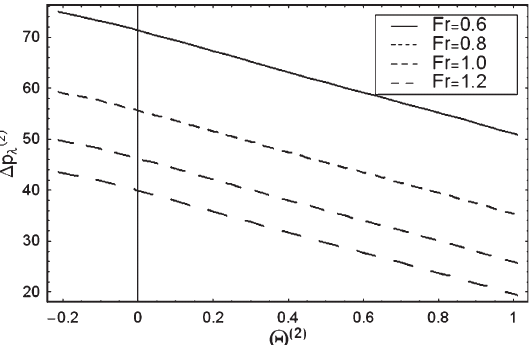
Fig. 3. Effect of Deborah number (cid:15) on variation of (cid:16)p (2) for a = 0 . 2, b = 0 . 5, d = 0 . 8, Re = 10, β = 0 . 1, Fr = 1, sin α = 0 . 5 and φ = π/ 4.